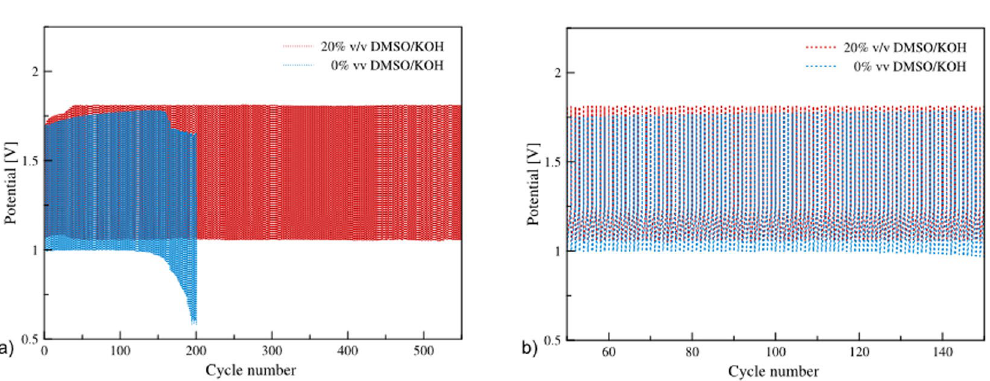
Figure 6. Galvanostatic charge/discharge profiles of the batteries using different electrolytes with the electrolyte circulation rate of 100c/min and repeated cycling discharge 75 mA/cm 2 for 5 mAh and charge 25 mA/cm 2 for 5 mAh: ( a ) during 1th-600th cycle, and ( b ) during 50 th –150 th